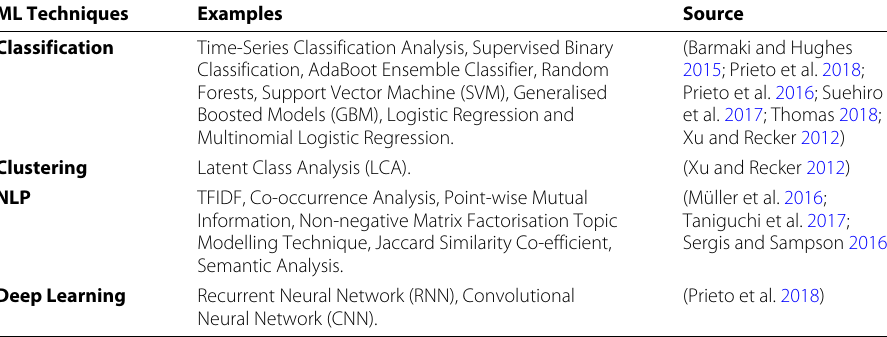
Table 3 ML Techniques used in